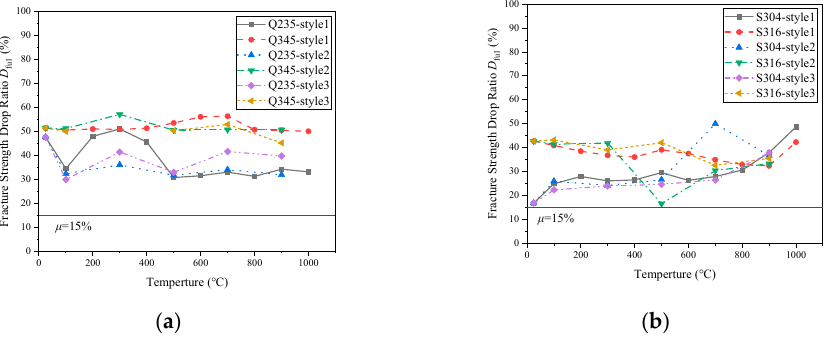
Figure 9. Fracture strength drop ratio. ( a ) Q235 and Q345; ( b ) S304 and S316.